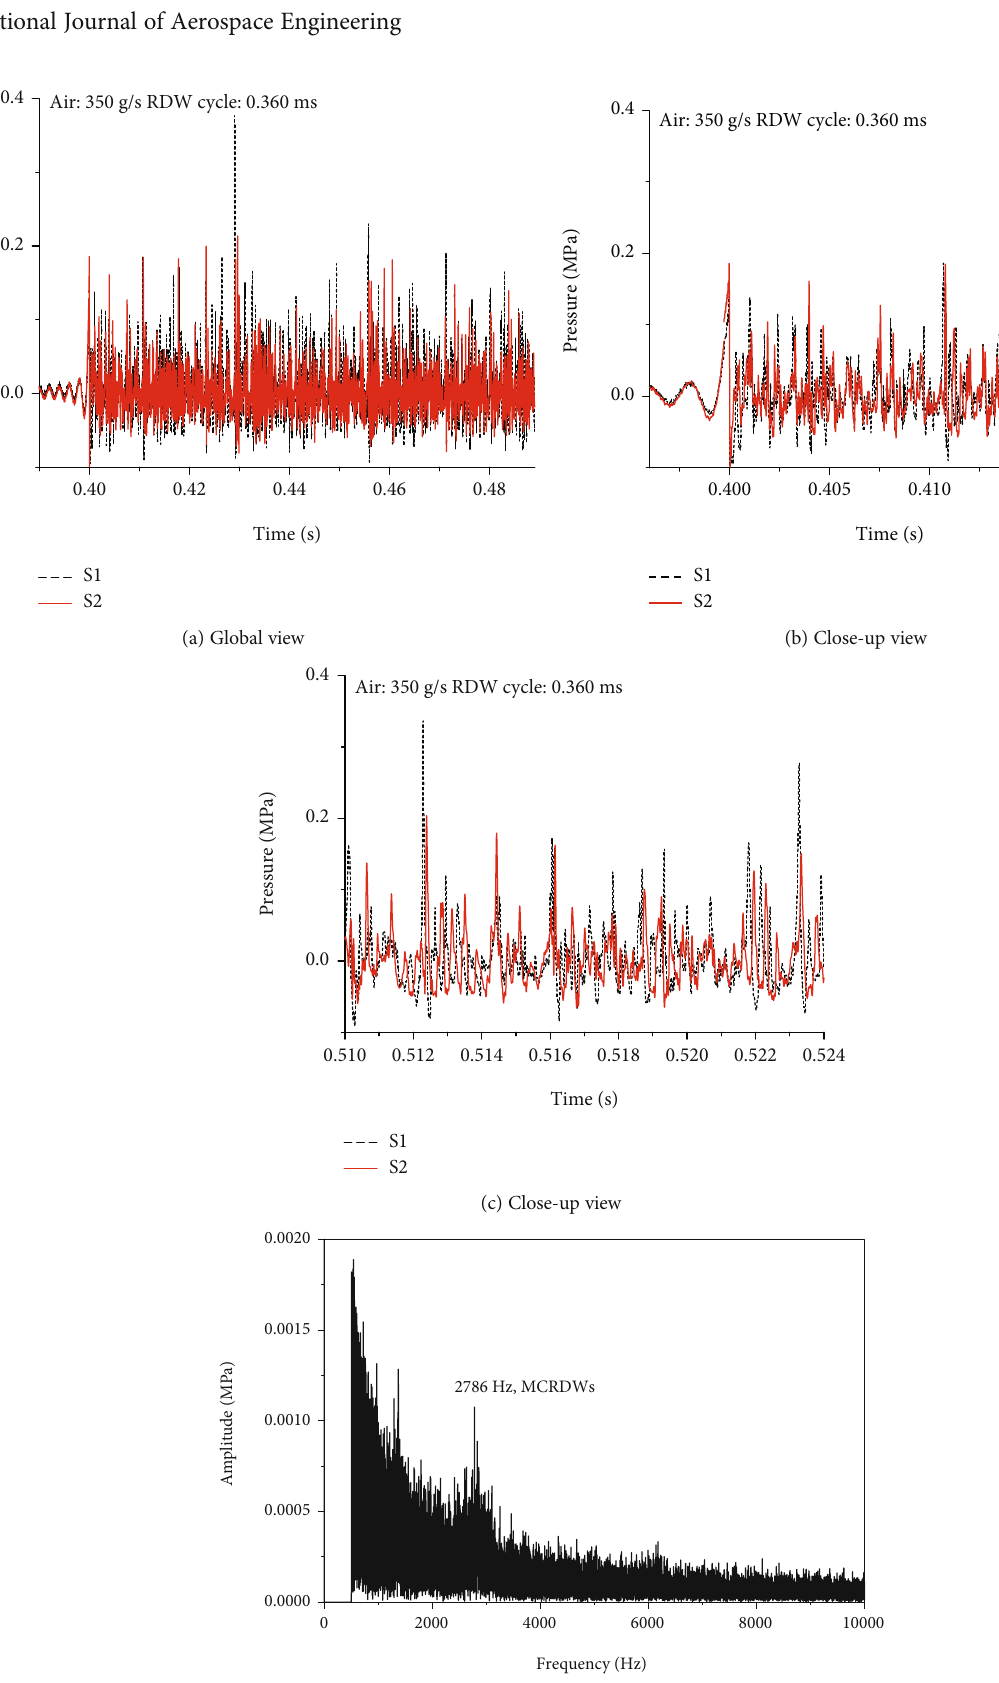
(d) Fast Fourier transformation for S1 Figure 3: Pressure traces obtained by S1 and S2 for the air mass fl ow rate